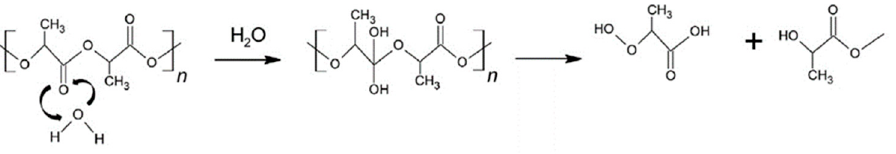
Figure 8. Mechanism of PLA hydrolysis in distilled water.